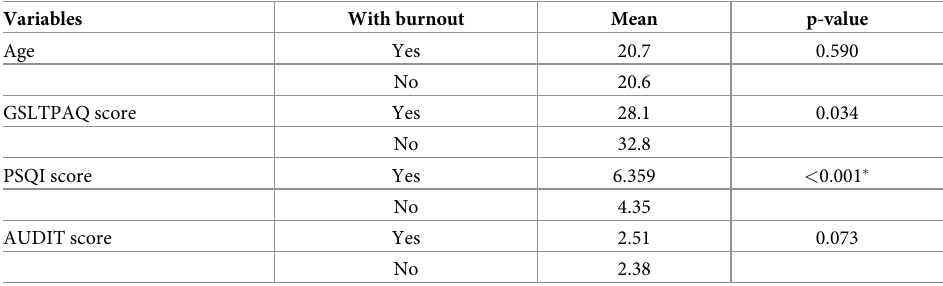
Table 2. Relationship between demographics/lifestyle factors (continuous data) and